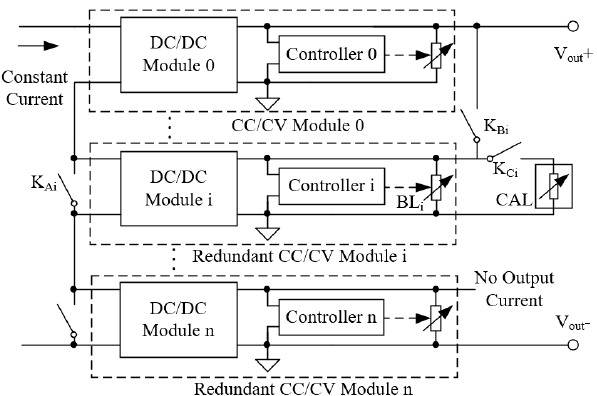
Figure 7. The equivalent schematic block when CC/CV module i is redundant and needs to be bypassed.